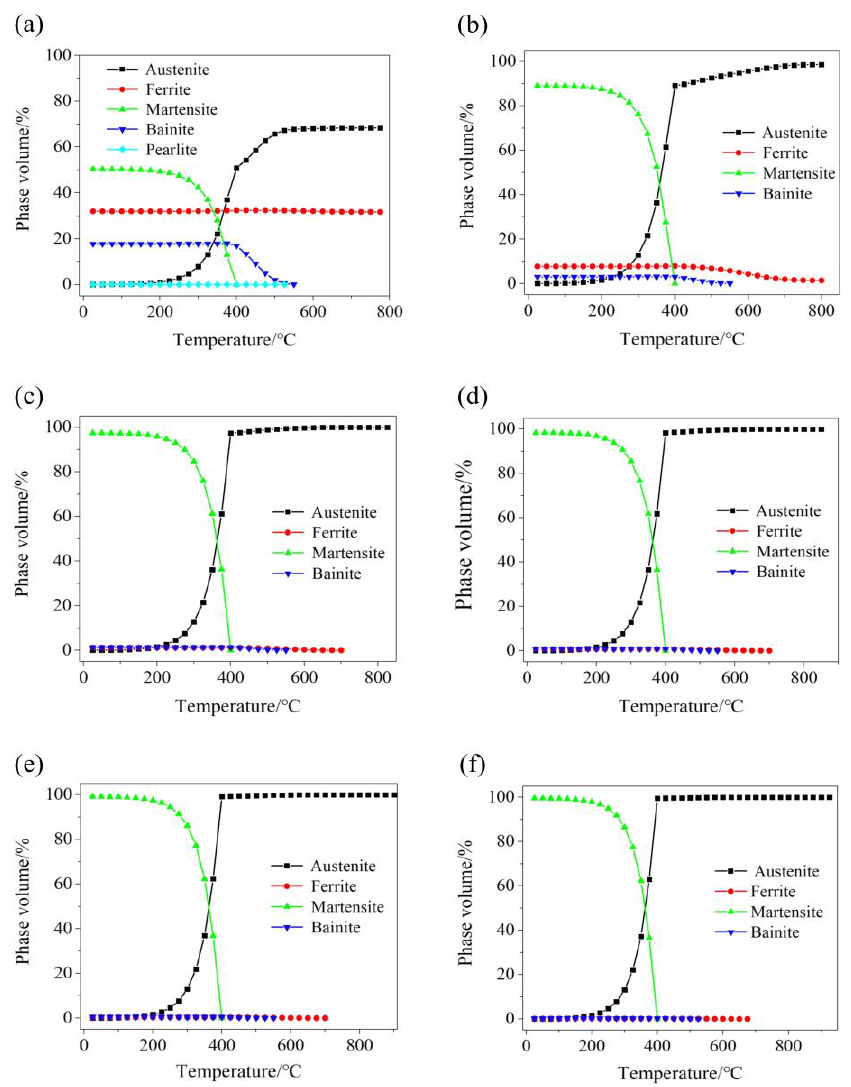
Figure 5. Thermodynamic calculations of the phase transitions of 22MnB5NbV at different austenitizing temperatures: ( a ) 780 °C; ( b ) 810 °C; ( c ) 840 °C; ( d ) 870 °C; ( e ) 900 °C; ( f ) 930 °C.